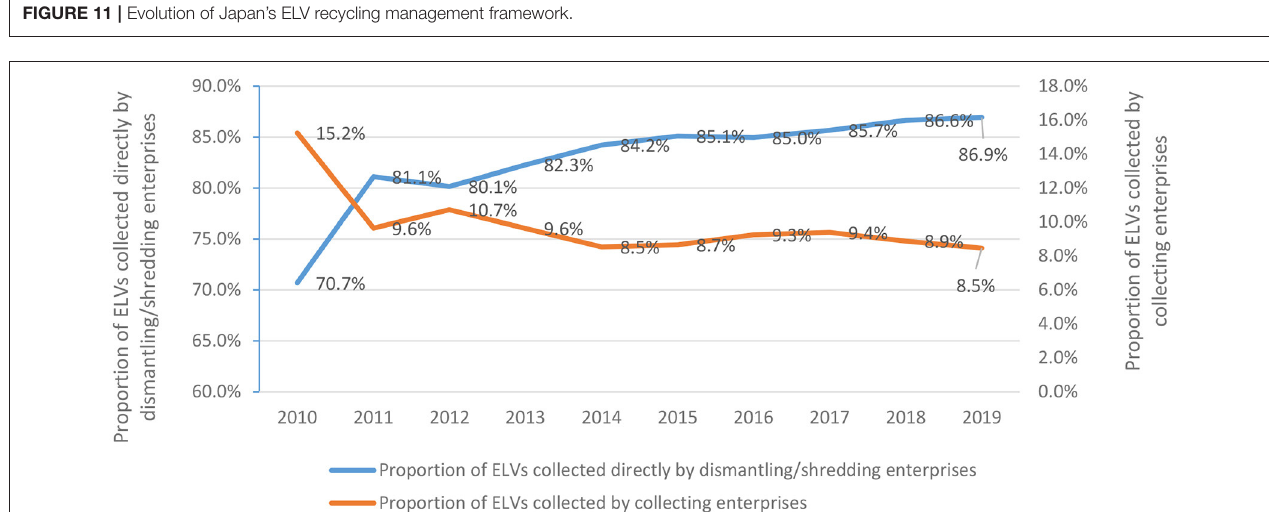
FIGURE 11 | Evolution of Japan’s ELV recycling management framework.